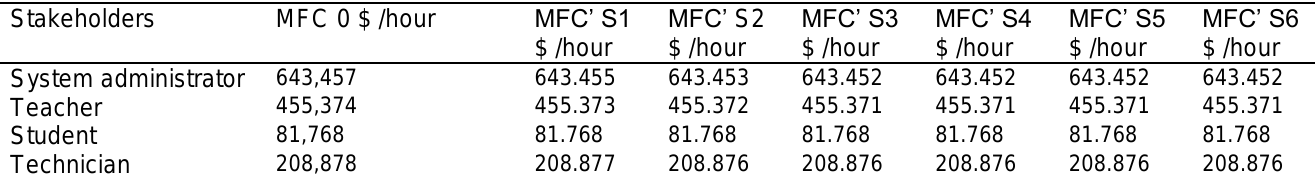
Table 15: MFC‘Si application for e -learning systems for the DB